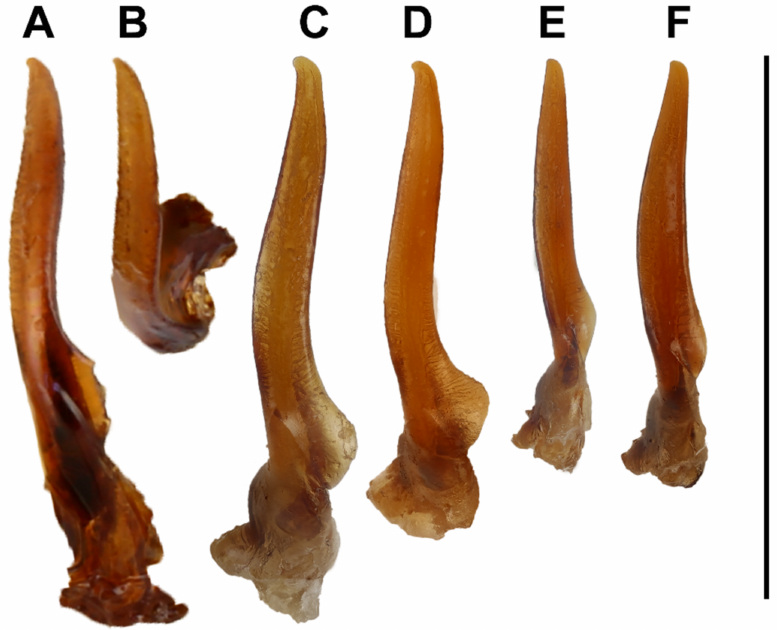
Figure 3. Penis in ventral view of Laccophilus alluaudi species group members from Comoro Islands: ( A ) L. tigrinus (PT 13265); ( B ) L. tigrinus (HT 13263); ( C ) L. denticulatus ; ( D ) L. mohelicus ; ( E ) L. mayottei ; ( F ) L. michaelbalkei . Scale bar 1 mm. Note that ( A , B ) (Photos: MNHN/Christophe Rivier) are photographed under different circumstances (equipment, angle and